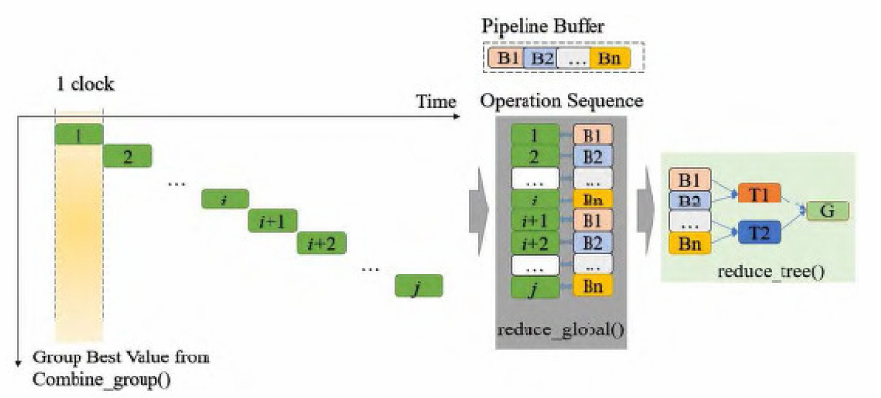
Figure 14. Clock initiation interval by using pipeline buffer [50] (Reprinted with permission from ref. [50]. Copyright 2021 IEEE).